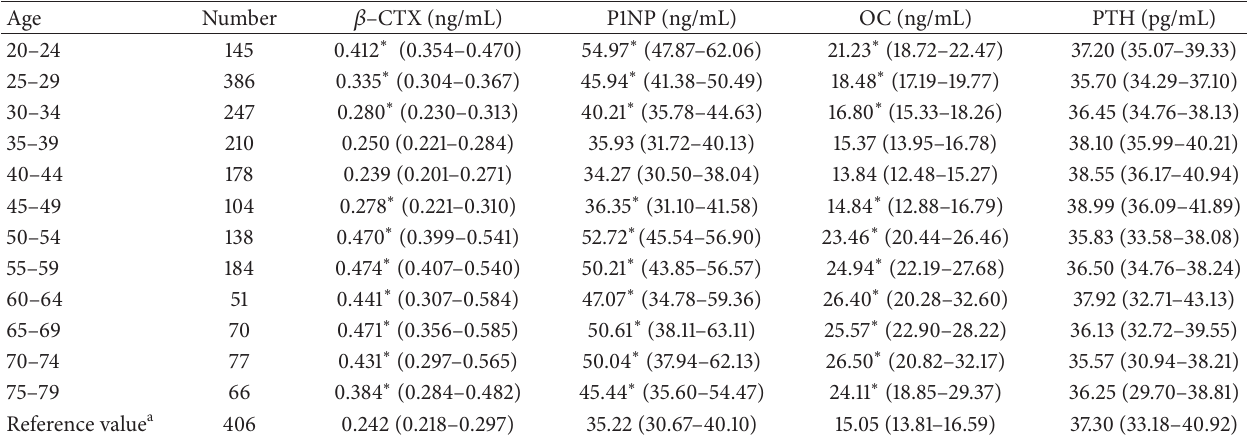
Table 3: Geometric means and 95% confidence intervals (95% CI) for the age-specific measurements of bone turnover markers in healthy